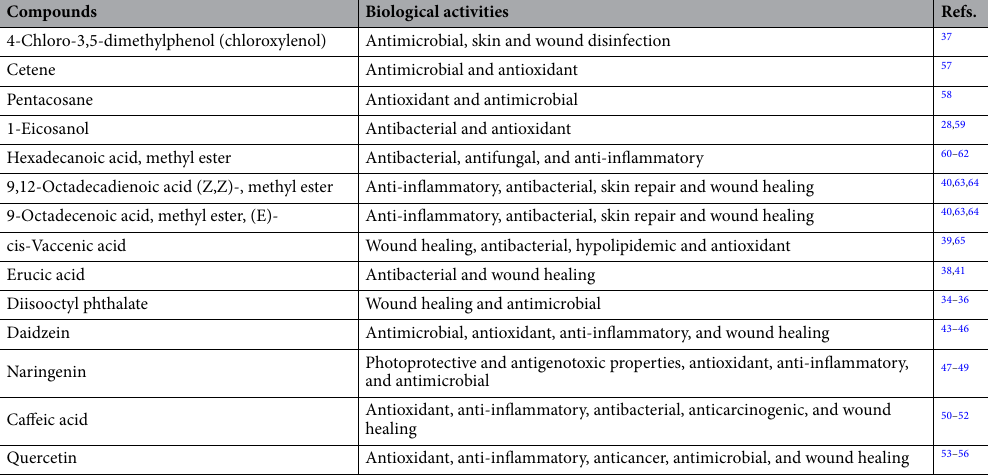
Table 3. Biological activities of some compounds identified from ethyl acetate crude extract of Paecilomyces sp. (AUMC 15510).